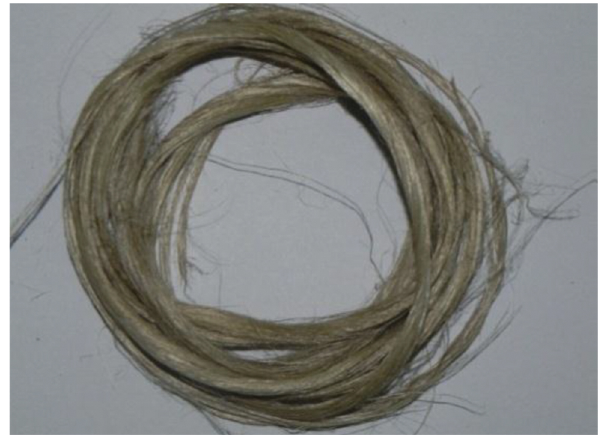
Figure 2: Raw jute fiber.